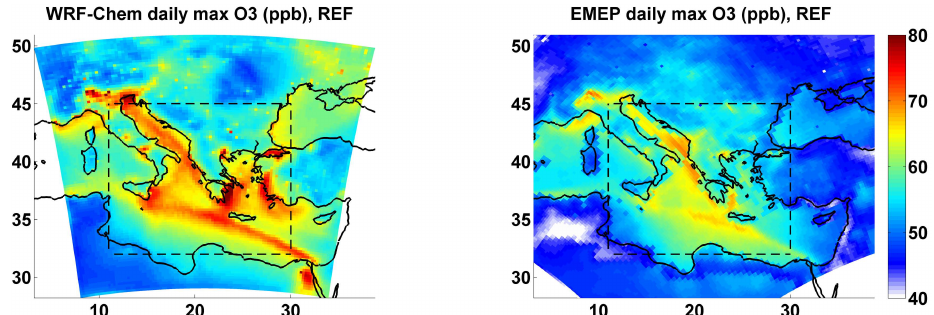
Fig. 10. Daily maximum near-surface ozone (ppbv) calculated by WRF-Chem (left) and EMEP MSC-W (right) averaged over the summer (JJA) 2007. The dashed rectangle marks the common EM region.